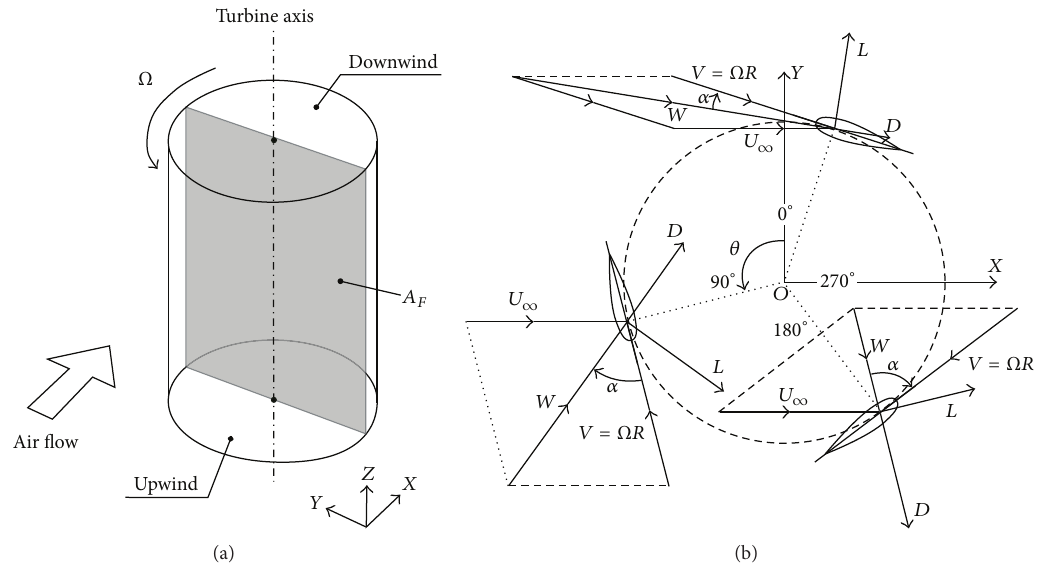
Figure 2: (a) Conceptual visualization of a VAWT. (b) Forces and velocities on a Darrieus turbine